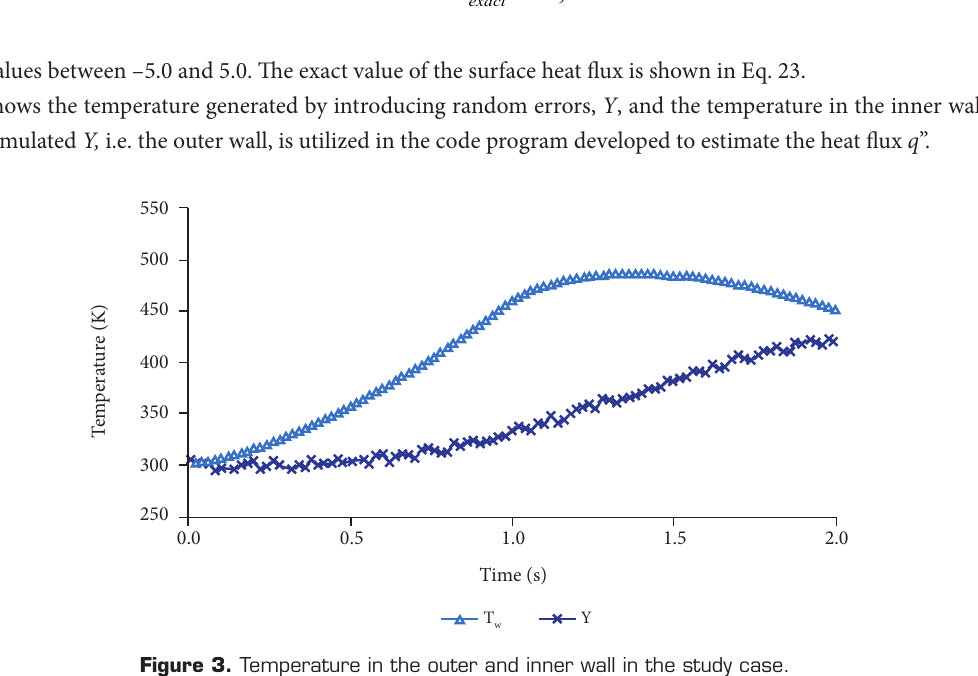
Table 1. Physical properties hypothetic problem.